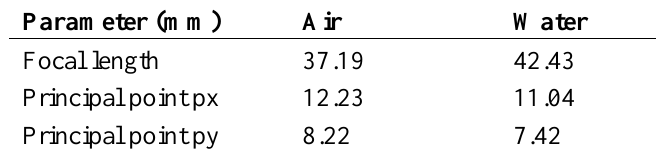
Table 2. Intrinsic parameters (mean values for left and right camera) in air and water (RGB images).